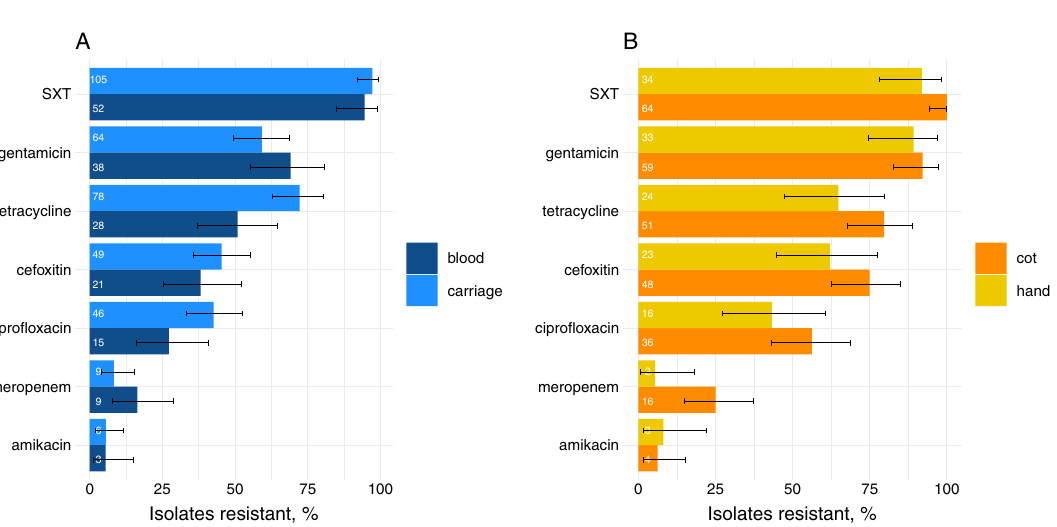
Figure 2. Frequencies of resistances in Gram-negative bacteria isolated from blood, and rectal, maternal hand and cot swabs. ( A ) Frequencies of antimicrobial resistances in blood (dark blue) and carriage (light blue), 3GC- RO only. ( B ) Frequencies of antimicrobial resistances in cot (orange) and maternal hand swabs (yellow), all 3GC-RO. Error bars show 95% confidence intervals. SXT